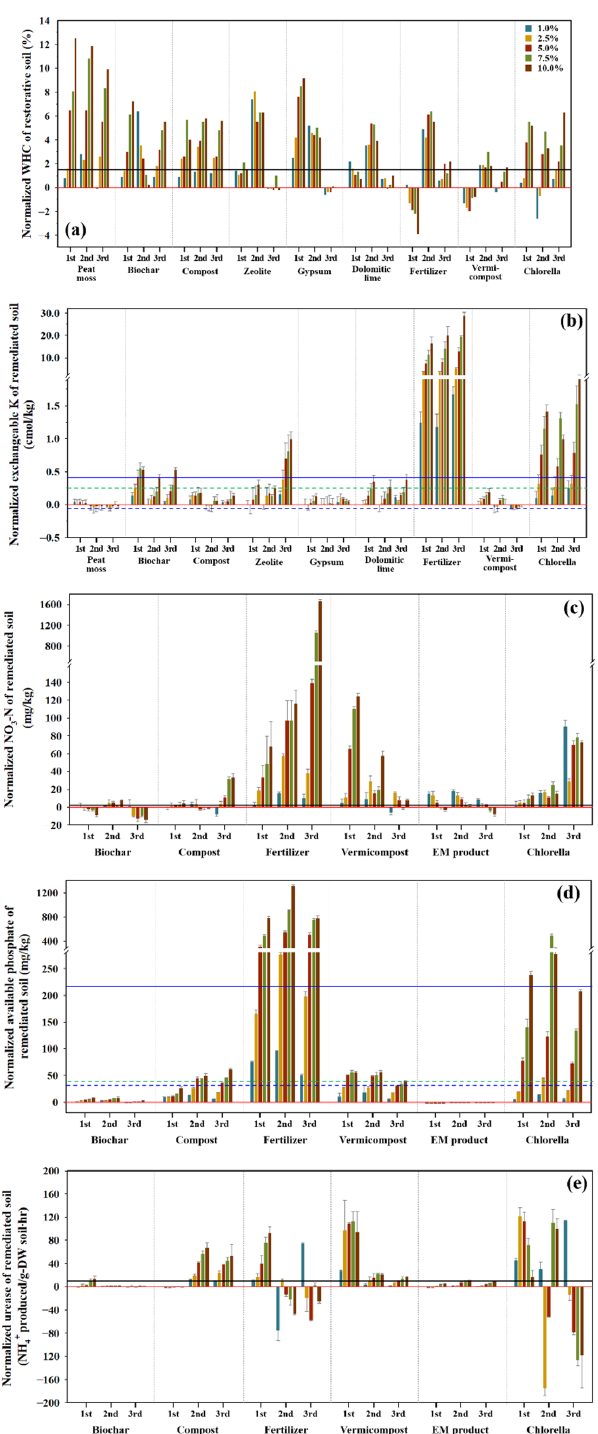
Figure 1. Changes in soil properties according to the dosage of each amendment and the duration of treatment. ( a ) Water holding capacity (WHC), ( b ) exchangeable K (Ex. K), ( c ) nitrate-nitrogen (NO 3 -N), ( d ) available phosphorus (Av. P), and ( e ) Urease (Ure). The first, second, and third periods mean after 2, 6, 10 weeks of treatment. The blue and blue dotted lines are the upper and lower limits of the criteria of soil quality standard for agricultural uses, respectively. The green dotted line is the lower limit of the criteria of soil quality standard for landscape (forest field) uses and the black line is the properties of non-contaminated soil (NS). Each result was normalized by subtracting the values of remediated soil (RS) from the values of restored